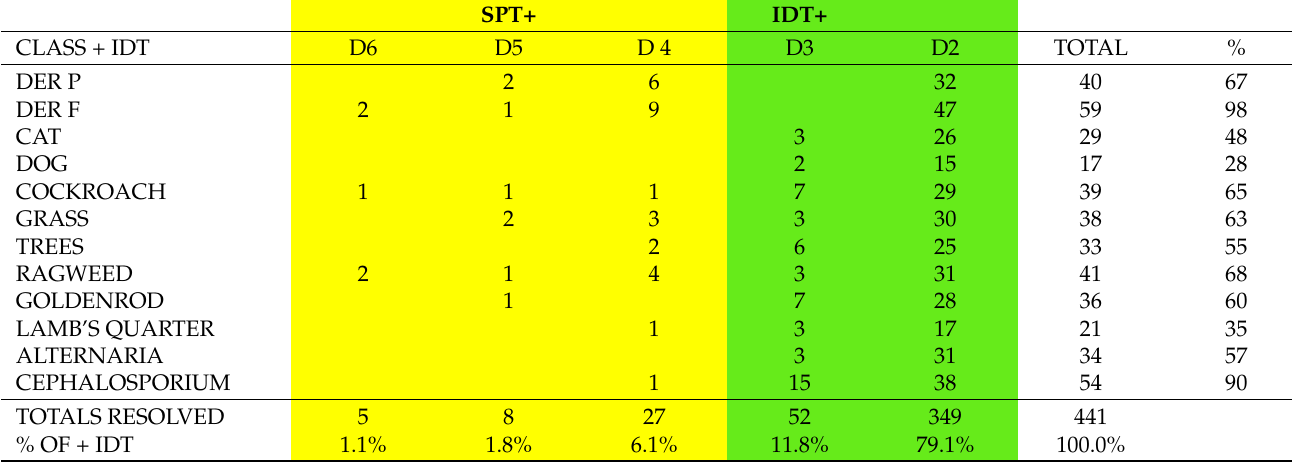
Table 5. IDT end points for 12 allergens in 60 OME patients whose otologic symptoms resolved with immunotherapy